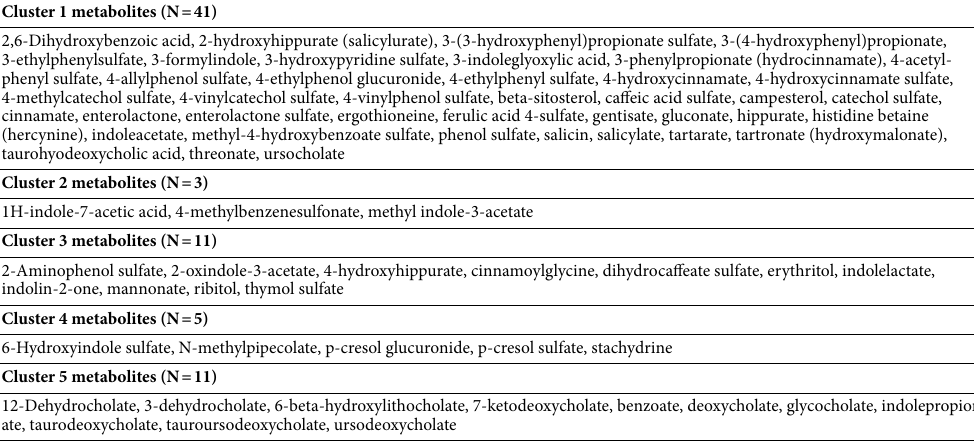
Table 2. MDPs that drive dimensions 1 and 2 in hierarchical clustering. The PCA loadings for these metabolites are presented in Supplemental Table S2, and are depicted in Fig. 2b. N = 9 control and N = 8 alcohol-treated